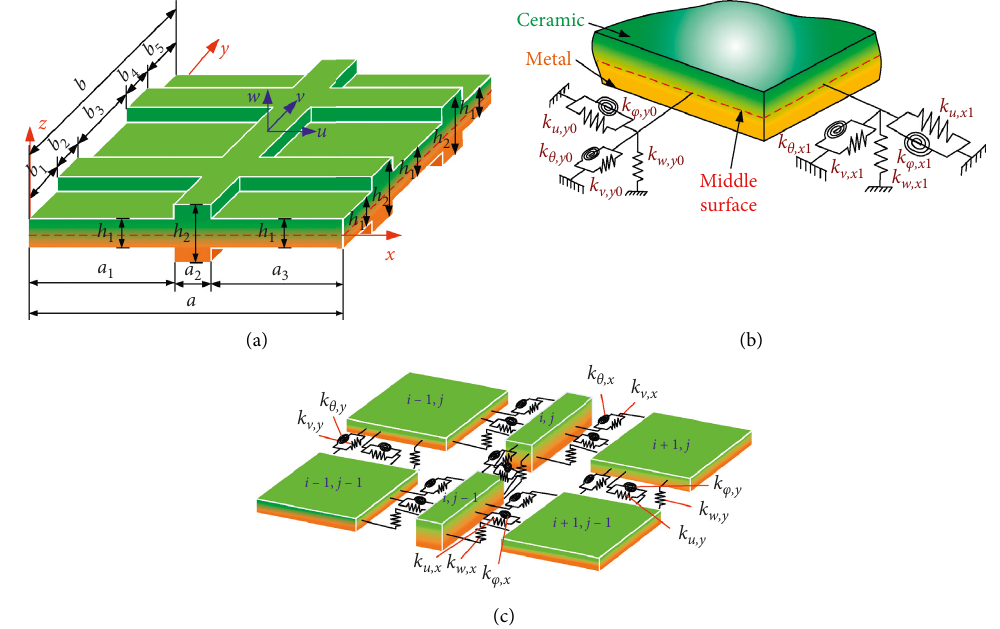
Figure 1: Multi-stepped FG-CNTRC plate model. (a) Geometric relationship. (b) Boundary condition. (c) Combined